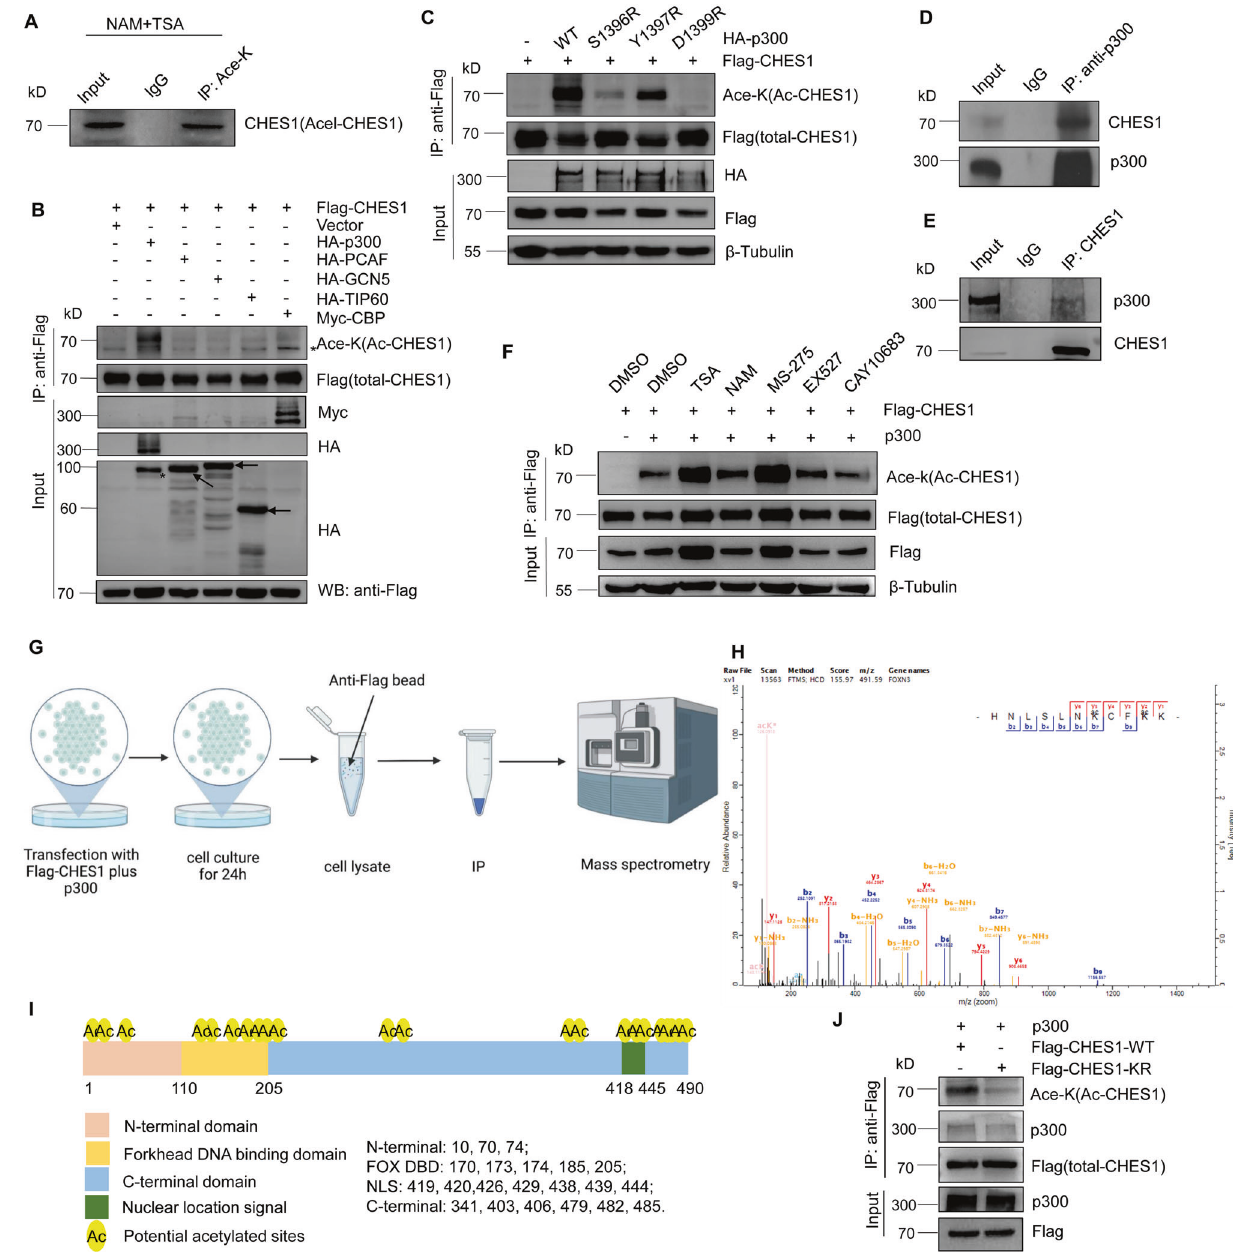
speci fi c band. C CoIP assay showed the disability of catalytic de fi cient mutants of p300 on the acetylation of CHES1. D , E CoIP assay showed the endogenous interaction between CHES1 and p300 in TNBC. F IP assay showed the effect of HDACs inhibitors on the acetylation levels of CHES1. G The schematic diagram of the main steps for identifying the acetylation lysine sites of CHES1 by mass spectrometry (MS). H Tandem mass spectrum of the peptide (m/z = 491.59) HNLSLNKCFKK containing acetylated K170 and K173 of CHES1. The “ ac ” above the Lys indicates an acetyl remnant on this Lys. I The schematic representation of the 21 acetylated lysine sites in the protein domains of CHES1. J CoIP assay showed the acetylation levels of wild type CHES1 and its KR